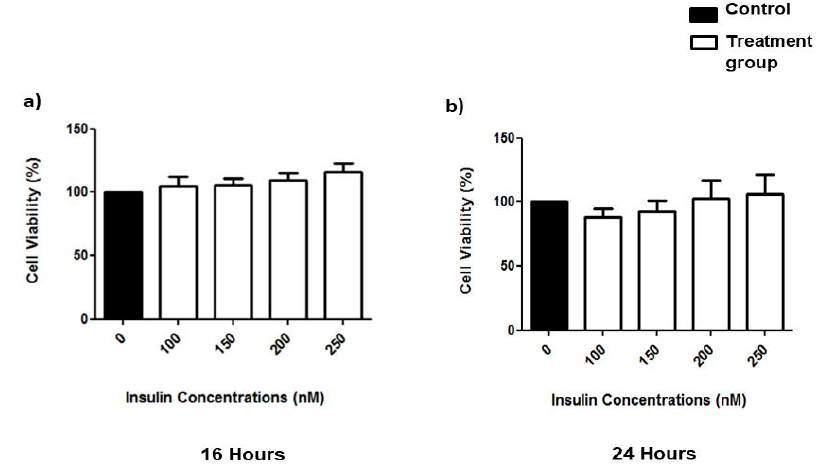
Figure 1. Effects of prolonged insulin induction on cell viability with different concentrations (100–250 nM) in SK-N-SH cell line incubated for ( a ) 16 and ( b ) 24 h, respectively. Cell viability was measured with an MTT assay. Data were expressed as mean ± SEM of three independent